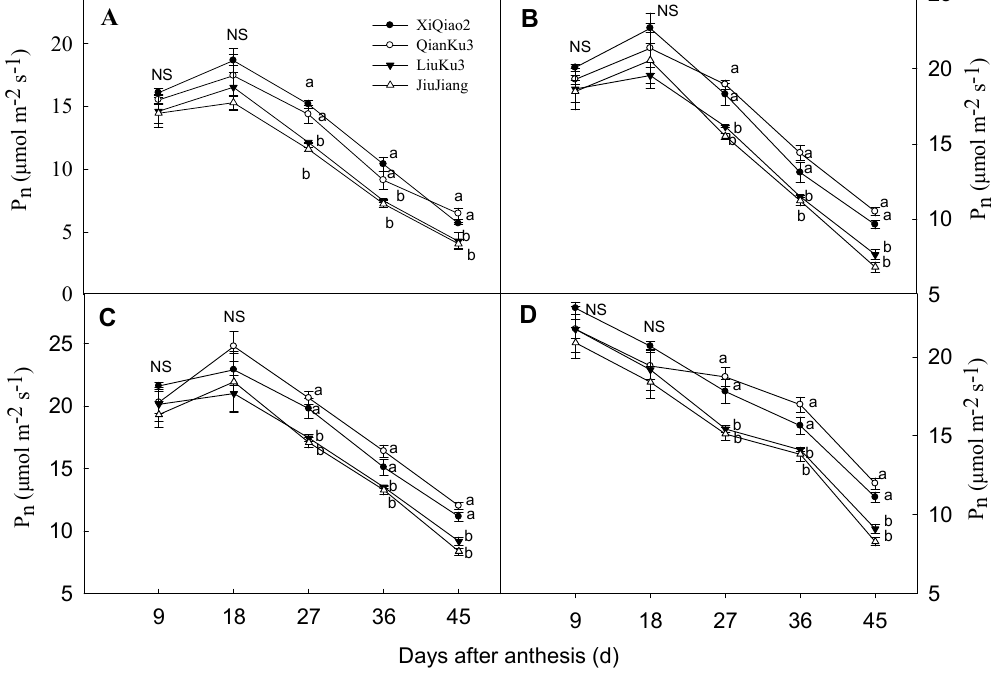
Figure 3. Net photosynthetic rates (P n ) in the leaves of four Tartary buckwheat cultivars at different flowering nodes. Panels ( A – D ) show results for the leaves of the 6th, 7th, 8th, and 9th flowering nodes, respectively. Data are means ± SD of two years (2016 and 2017). Letters a and b denote significant differences between cultivars ( p < 0.05) in P n at the same day after anthesis. NS: no significant difference.